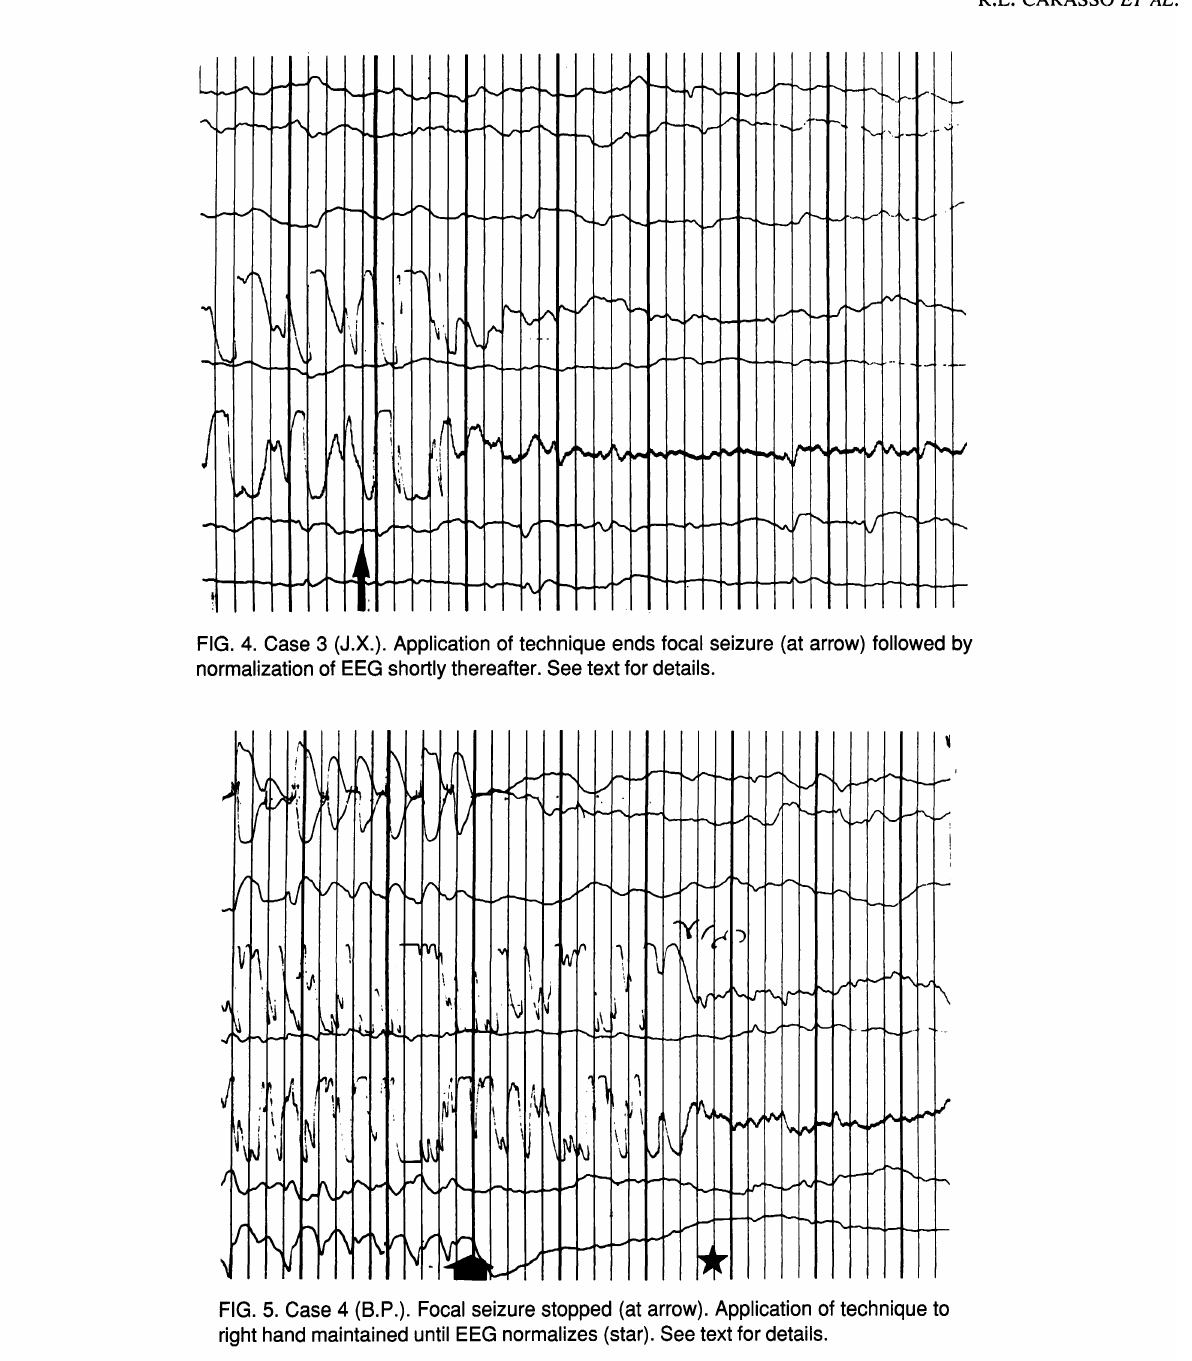
FIG. 5. Case 4 (B.P.). Focal seizure stopped (at arrow). Application of technique to right hand maintained until EEG normalizes (star). See text for